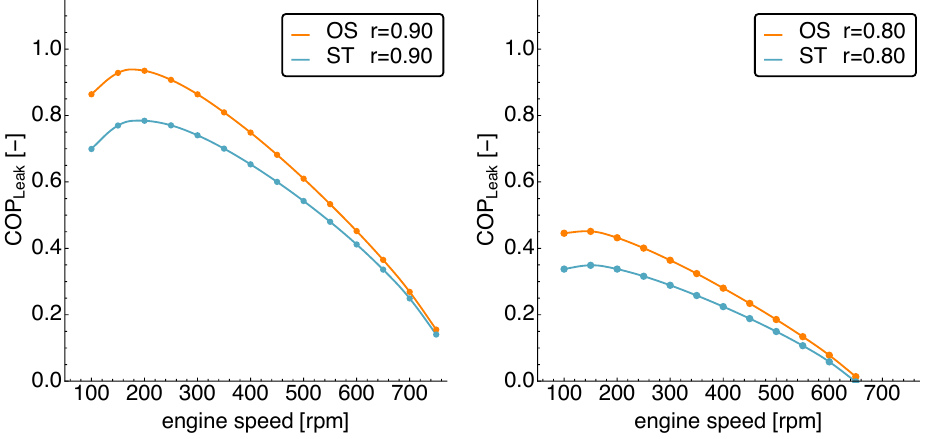
Figure 7. The standard case COP vs. engine speed for OS and ST motion at different values of the regeneration coefficient ( left / right ) under the influence of a heat leak of κ Leak = 5W/K. Again, a larger regeneration coefficient allows for higher COP values, and the slower the engine operates, the larger the COP gain by optimized piston motion (OS) is. At very low operating speeds, the standard case COP decreases due to the heat